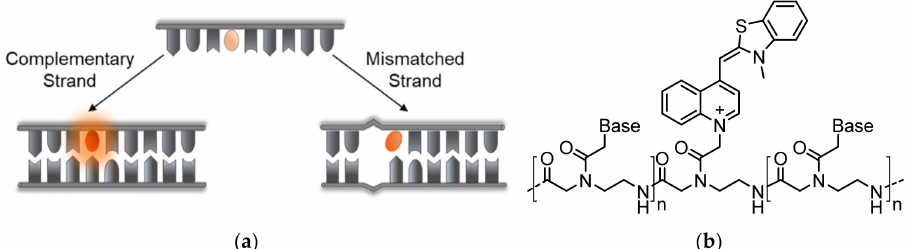
Figure 4. PNA-based FIT-probes. ( a ) The operating mechanism of FIT-probes: an internally embedded TO is forced to intercalate within a specific location of a formed duplex, thereby making it sensitive to local mismatched bases that affect its motion restriction and the resulting fluorescence; ( b ) The chemical structure of TO-based PNA